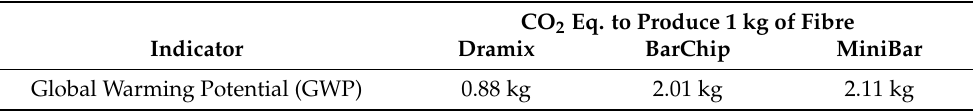
Table 6. Global warming potential to produce 1 kg of different fibres given as kg CO 2 equivalent. Data from